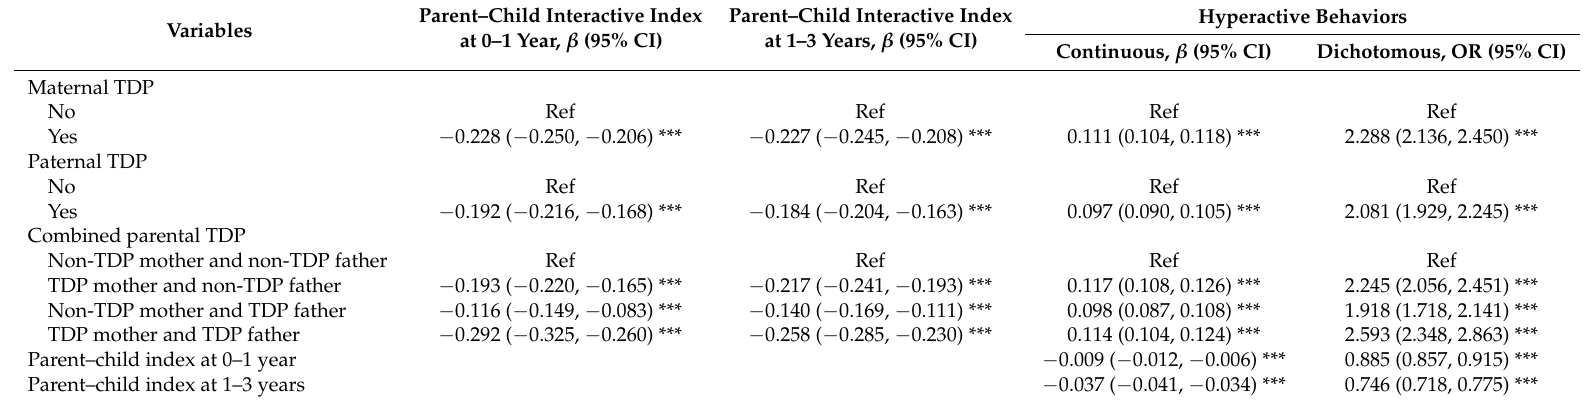
Table 2. Associations among parental TDP, parent–child interactive activities, and children’s hyperactive